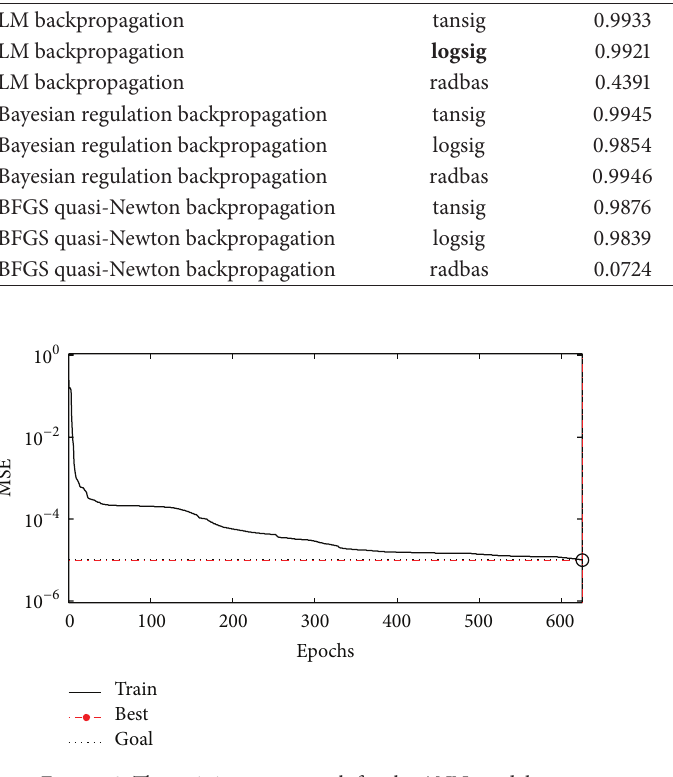
Figure 3: The training error graph for the ANN models.